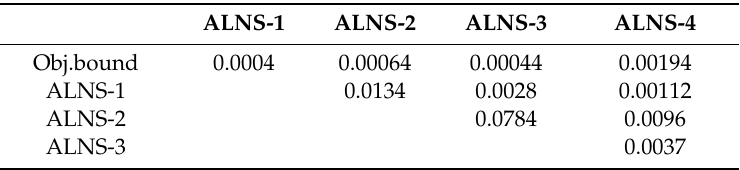
Table 11. Statistical test of the proposed heuristics.